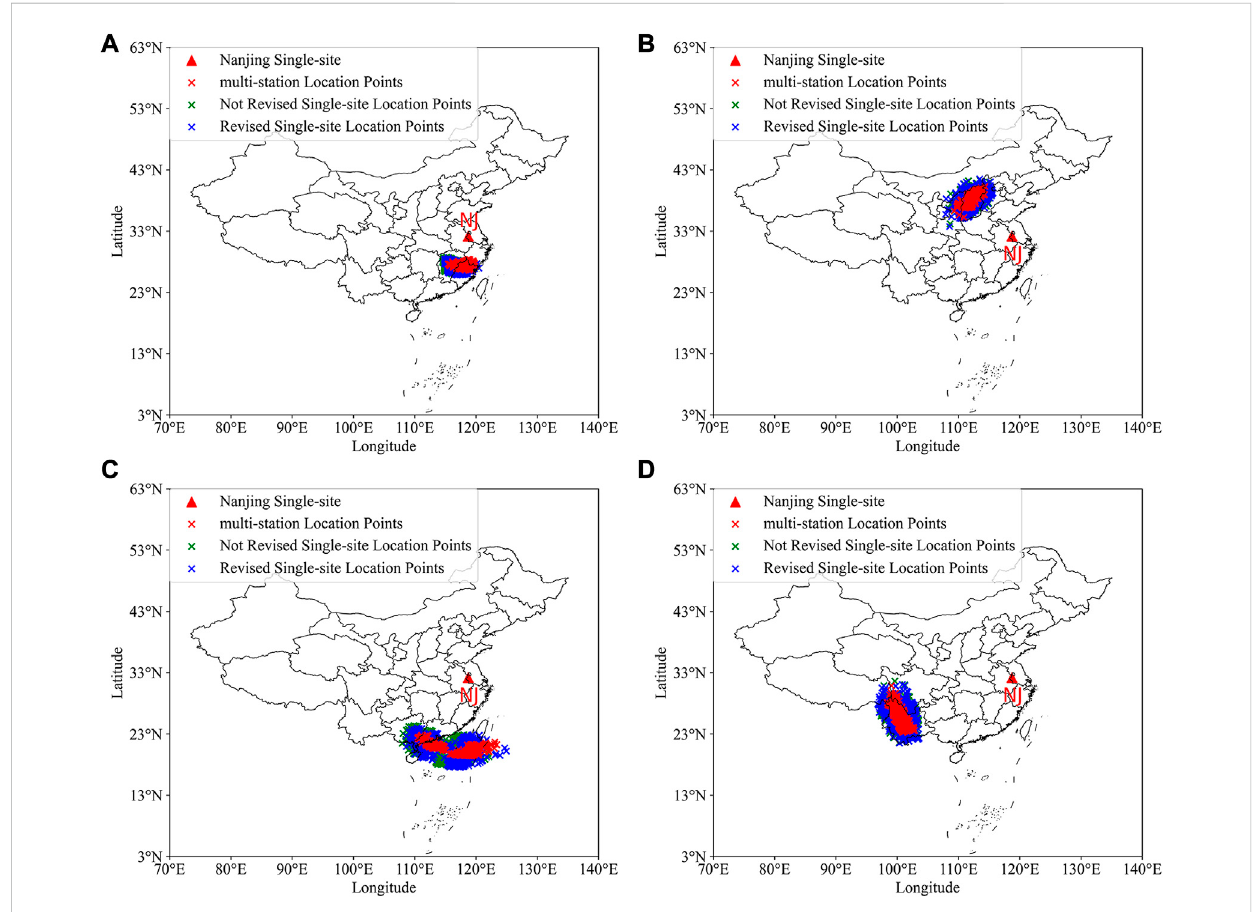
FIGURE 11 Lightning location results of single-site and multi-station. (A) In the range of 400 – 600 km; (B) In the range of 800 – 1000 km; (C) In the range of 1200 – 1400 km; (D) In the range of 1800 – 2000 km.